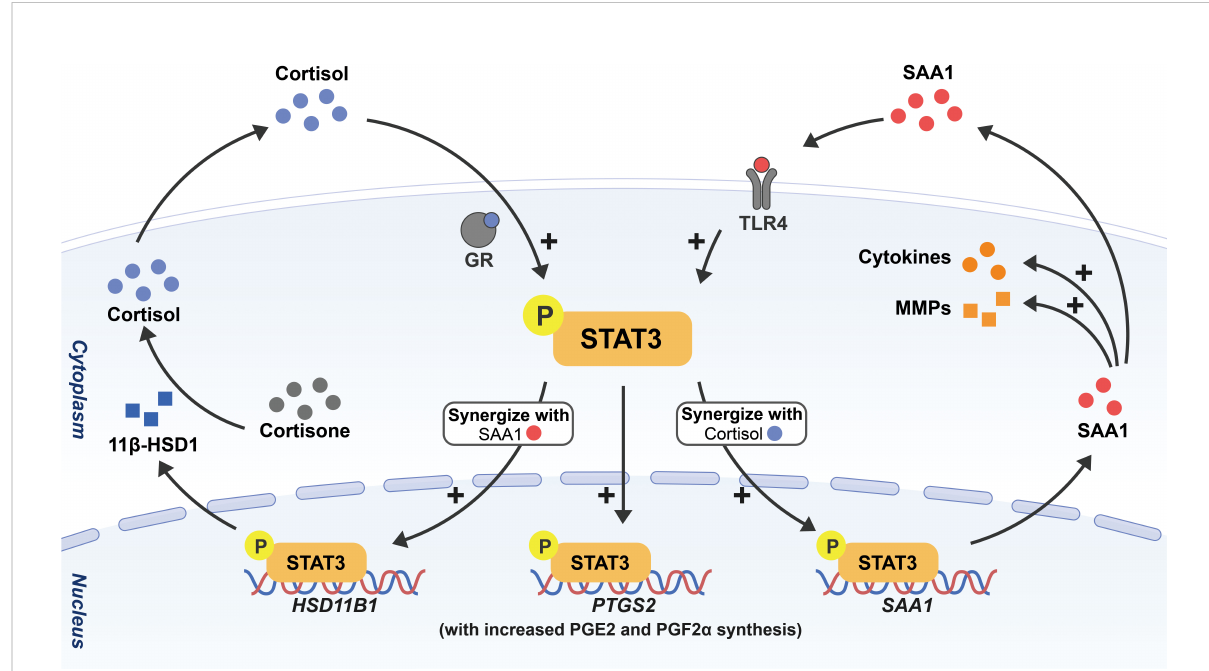
FIGURE 2 Schematic drawing depicting the feedforward loop among SAA, cortisol and prostaglandins in the activation of fetal membranes with STAT3 as a central transcription factor. Through phosphorylation of STAT3, cortisol and SAA1 can induce the expression of not only 11 b -HSD1 but also SAA1 per se synergistically in amnion fi broblasts, and in turn, 11 b -HSD1 converts biologically inactive cortisone to cortisol. Cortisol and SAA1 further stimulate the expression of COX-2 (encoded by PTGS2 ) with subsequent increased PGE2 and PGF2 a synthesis. In addition, SAA1 also increases the expression of a number of pro-in fl ammatory cytokines and MMPs in amnion fi broblasts. All these effects will lead to membrane activation and ECM remodeling in